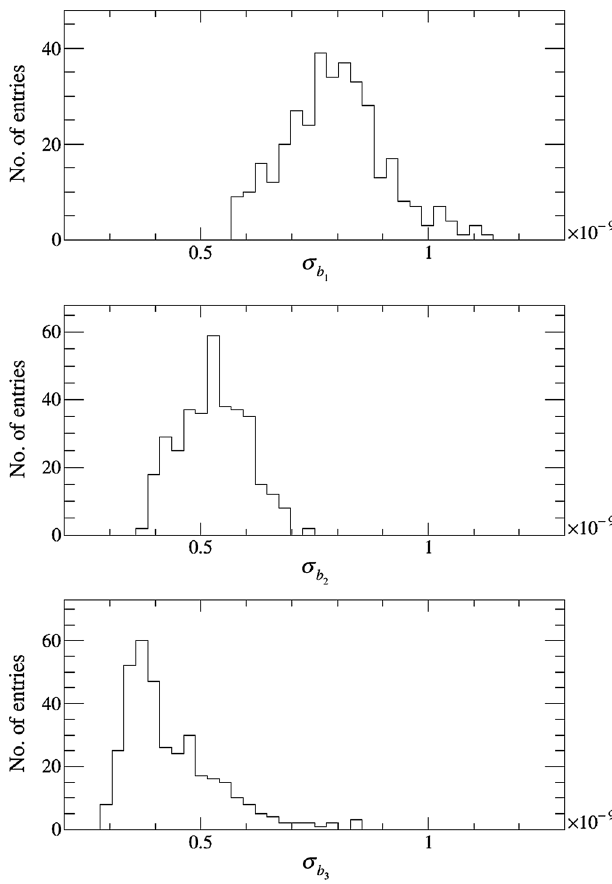
, σ , and σ of b 1 b 2 b 3